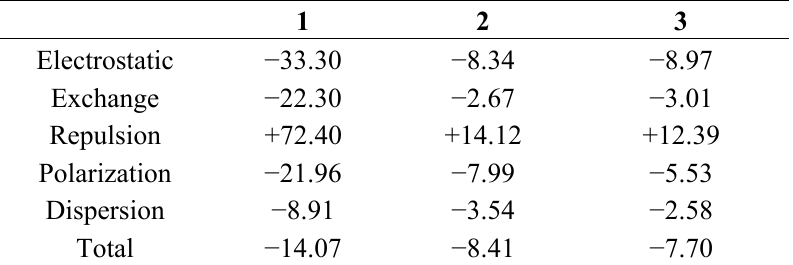
Table 1. LMOEDA decomposed energy terms in